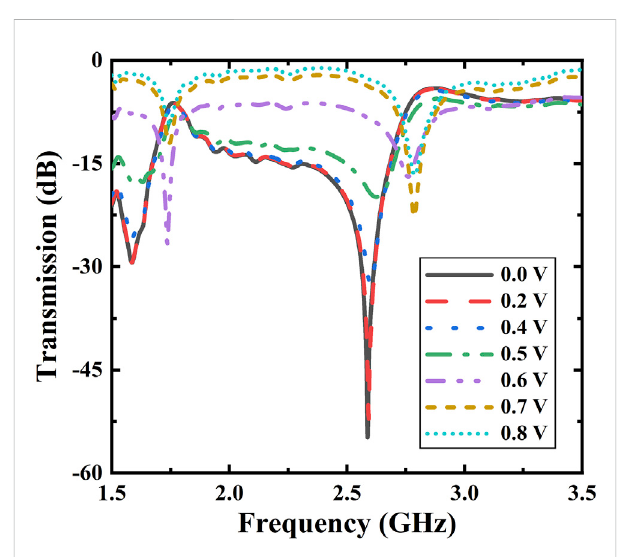
FIGURE 6 Measured transmission spectra of the tunable SEC-like meta- molecule under different biasing voltage changing from 0.0 V to 0.8